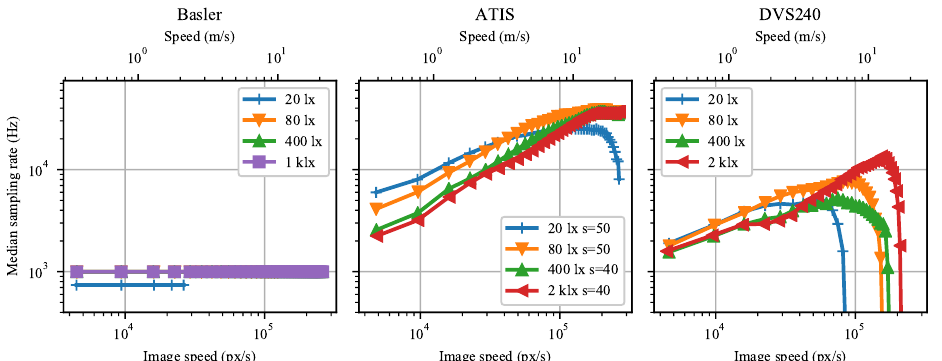
Figure 7. Sample images from the global shutter Basler camera. The green crosses show the ground truth position of the dot or marker center at the start of exposure. Exposure time 59 µ s, sensor illuminance 1000 lx.